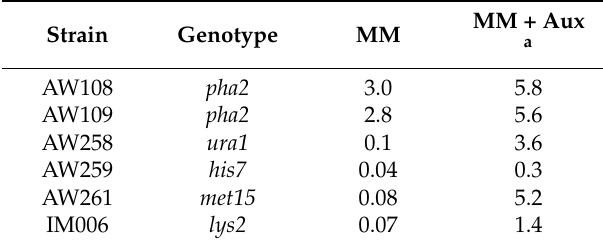
Table 4. Density of three-day-old cultures.